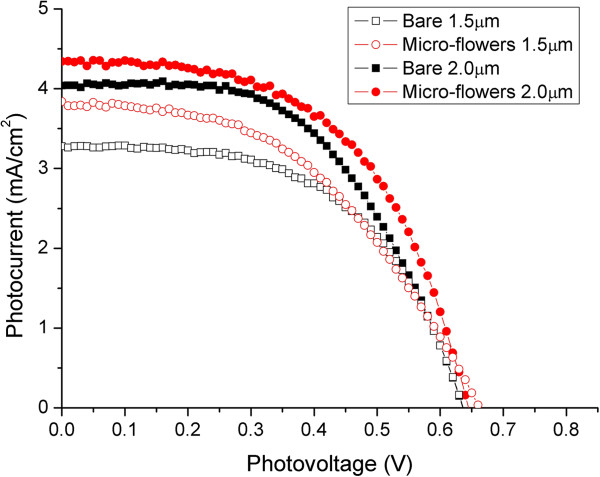
J-V characteristics of DSCs based on bare TiO2 nanotubes and TiO2 micro-flowers. The thicknesses of the TiO2 nanotubes are 1.5 and 2.0 μm.